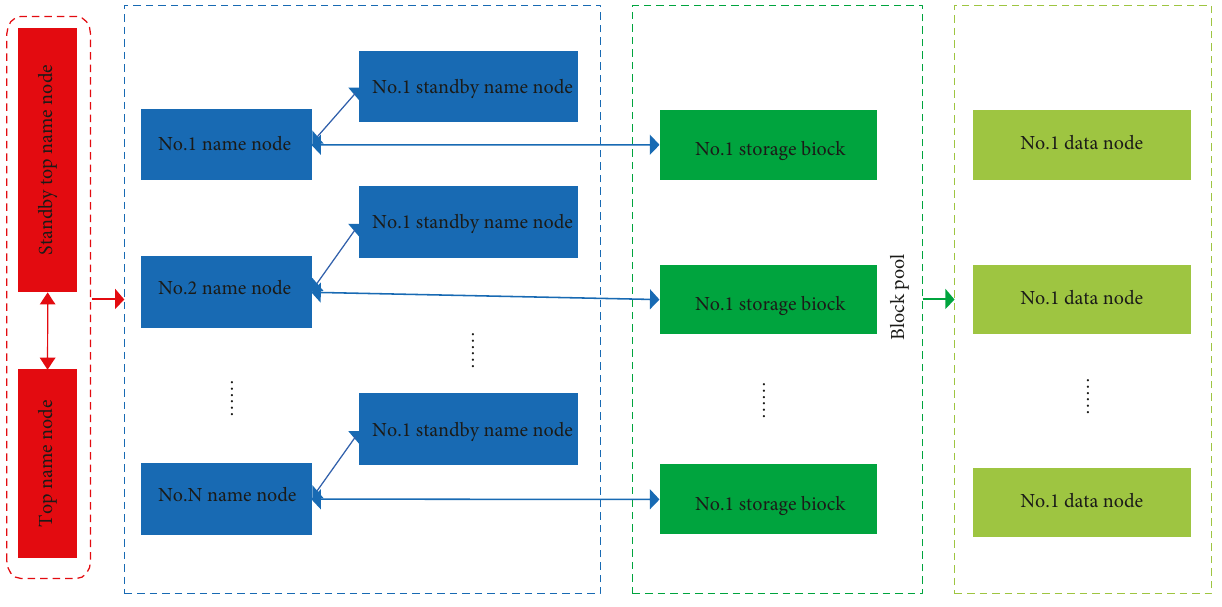
Figure 2: The structure diagram of the MBDP system for distributed